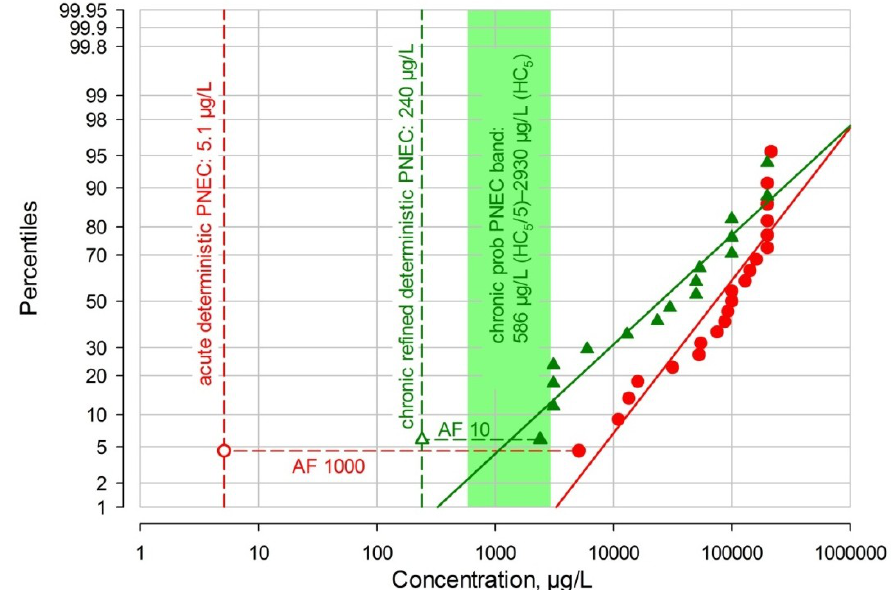
Figure 3. Acute and chronic ecotoxicity data, deterministic and probabilistic predicted no effect concentrations (PNECs) for